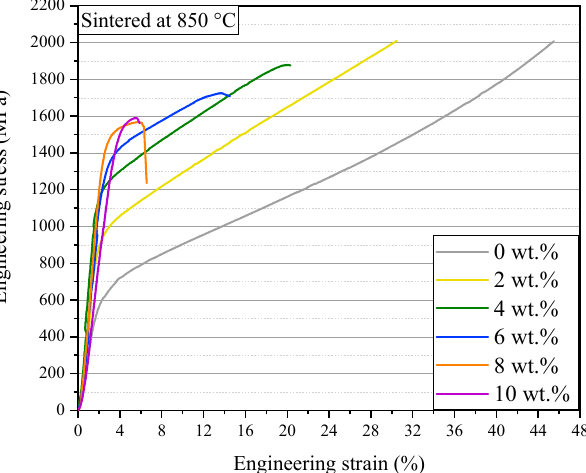
Figure 7. Stress–strain curves of the samples sintered at 850 ◦ C with different milled Ti content. Strength values (YS, compressive strength) determined on the measured curves show the same tendency as the hardness results. The samples without milled Ti content had an